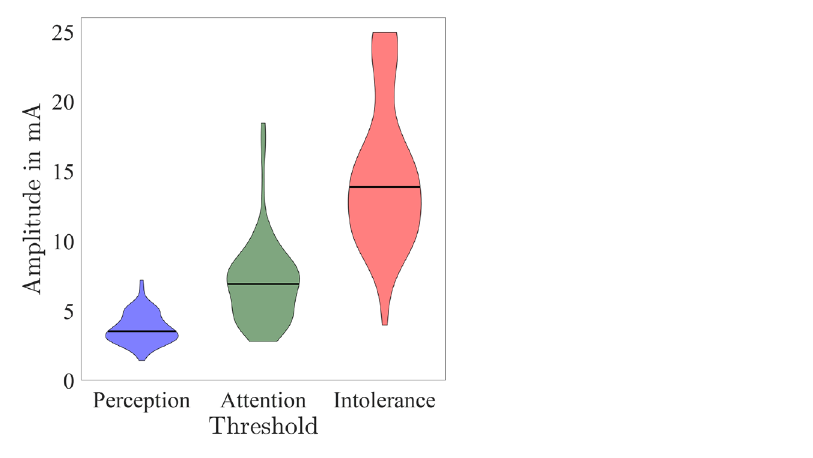
Figure 3. Distribution of perception (blue), attention (green), and intolerance thresholds (red) obtained during the reference threshold determination. The data represent the average over the last 3 measurements in the reference experiment at the beginning of each session, see text.